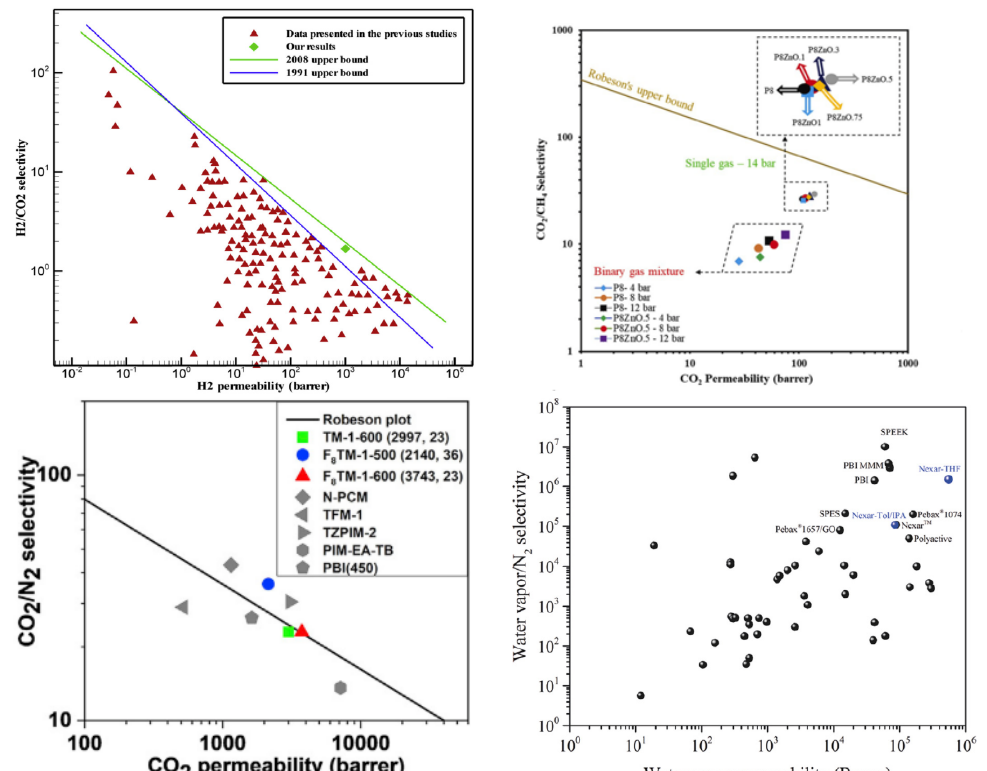
Figure 27. Robeson’s upper bound of various gases in different membranes